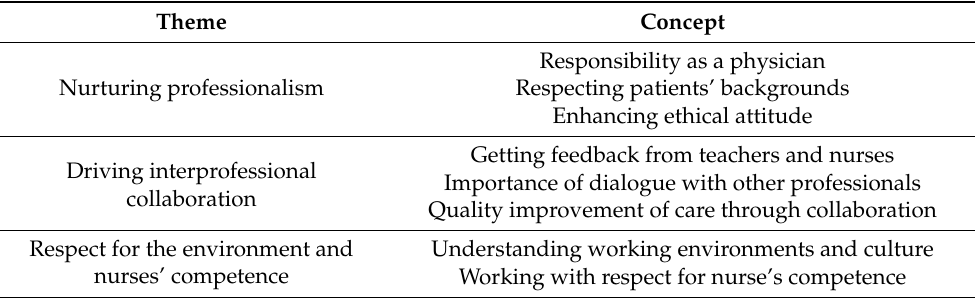
Table 2. Qualitative analysis of nurses’ role in family medicine